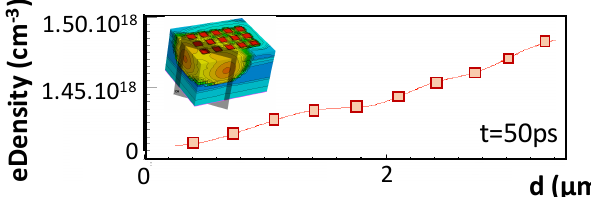
Fig. 9. Electron density along the particle track for the aluminum